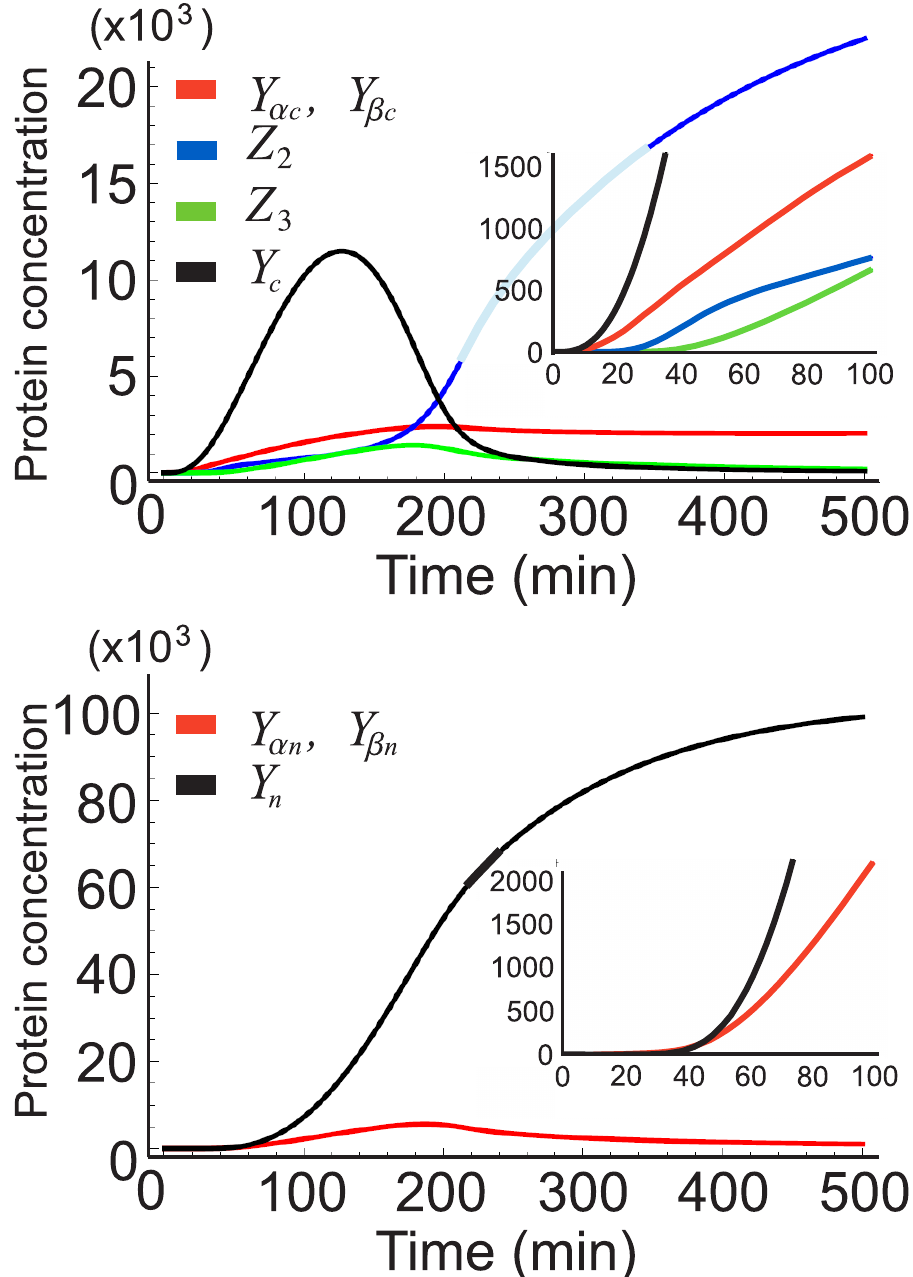
Fig 3. Evolution of average protein concentrations. A close-up view of the figure is given on the right-hand side A) Protein concentrations in the cytoplasm. At t = 0 all three genes are turned on. The cargo protein in the cytoplasm (black) begins to accumulate first, followed by the importin α and β (red). At about t = 20 min, importins α and β start forming heterodimers (blue), and 20 min after that, the concentration of importin- α − β -cargo complex (green) begins to rise. B) Protein concentrations in the nucleus. Both the cargo protein (black) and the importins α and β (red) start to accumulate at about t = 40